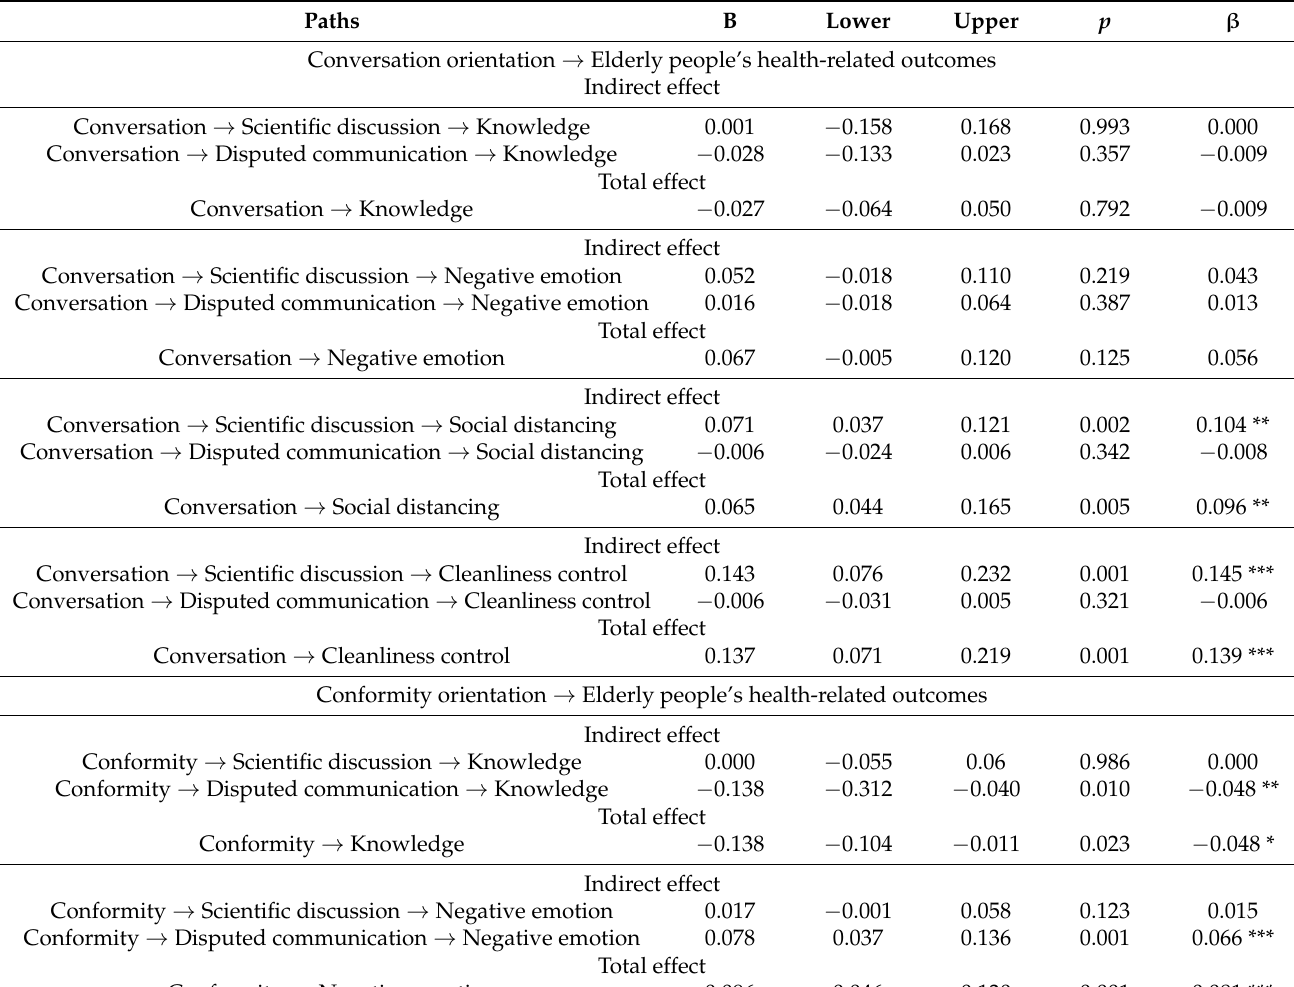
Table 4. Mediation effects of family communication patterns on elderly people’s health-related outcomes. Paths B Lower Upper p β Conversation orientation → Elderly people’s health-related